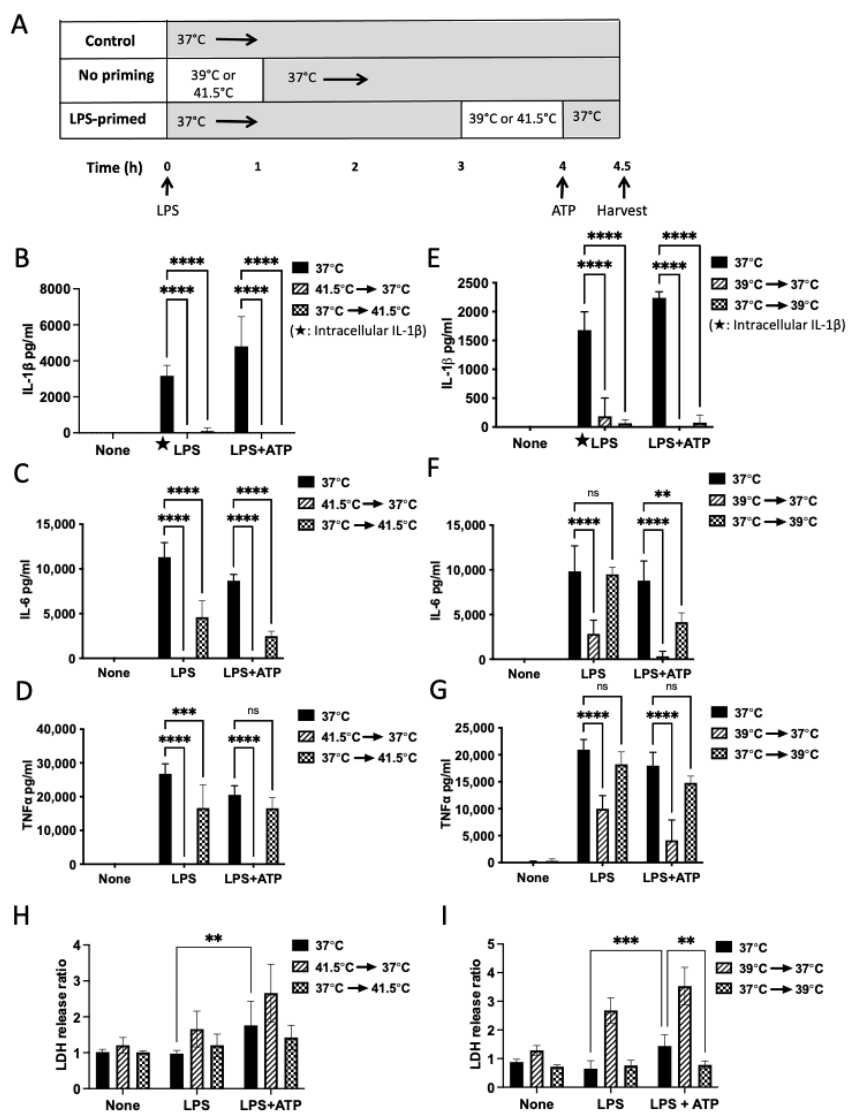
Figure 1. Mild and extreme heat shock differentially inhibit proinflammatory cytokines. ( A ) Timing of heat exposure and LPS/ATP stimulation in iBMMs. In each model, macrophages were treated with LPS (1 µ g/mL) for 4 h, then ATP (5 mM) was added for 30 min to induce the release of IL-1 β . Supernatants and cell lysate were analyzed by ELISA for cytokines and assayed for LDH release. One set of samples was incubated at 37 ◦ C for 4 h as a control (black bars). Co-exposure of the “no priming” model: cells were stimulated with LPS and incubated at 41.5 ◦ C or 39 ◦ C for 1 h, followed by incubation at 37 ◦ C for 3 h (hatched bars). “Priming” model: cells were stimulated with LPS and incubated at 37 ◦ C for 3 h, followed by incubation at 41.5 ◦ C or 39 ◦ C for one hour (checked bars). ( B – D ) The co-exposure model at 41.5 ◦ C shows inhibition of TNF α , IL-6, and intracellular IL-1 β (hatched bars, 41.5 ◦ C → 37 ◦ C). The primed model at 41.5 ◦ C shows some inhibition of TNF α and IL-6 and complete inhibition of IL-1 β (checked bars, 37 ◦ C → 41.5 ◦ C). ( E – G ) 39 ◦ C co-exposure model shows inhibition of IL-1 β , TNF α , and IL-6 (hatched bars). The primed model at 39 ◦ C shows inhibition of IL-1 β , but not TNF α and IL-6 (checked bars). ( H , I ) The LDH-release assay shows cell death in the co-exposure model at both temperatures (hatched bars), but not in the primed model (checked bars). Results are the combined results of 2–3 independent experiments (IL-1 β and LDH) or representative of 2–3 independent experiments (TNF α and IL-6). **** p < 0.0001 as determined by a two-way ANOVA with Tukey’s multicorrection comparison. *** p < 0.001, ** p < 0.01, ns—not